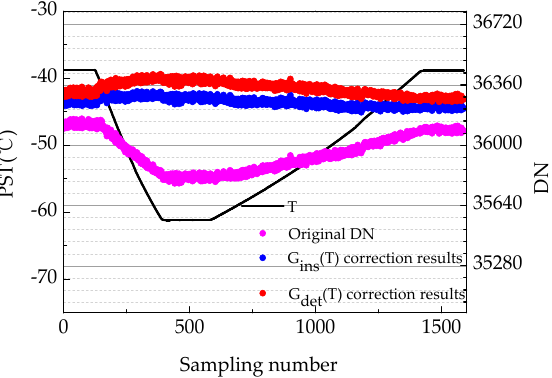
Figure 19. Comparison of two G(T) correction effects. The 1.08% fluctuation in DN when the T decreased from − 38 °C to − 61 °C was corrected to 0.38% and 0.34%, respectively, with G det (T) and G ins (T) .